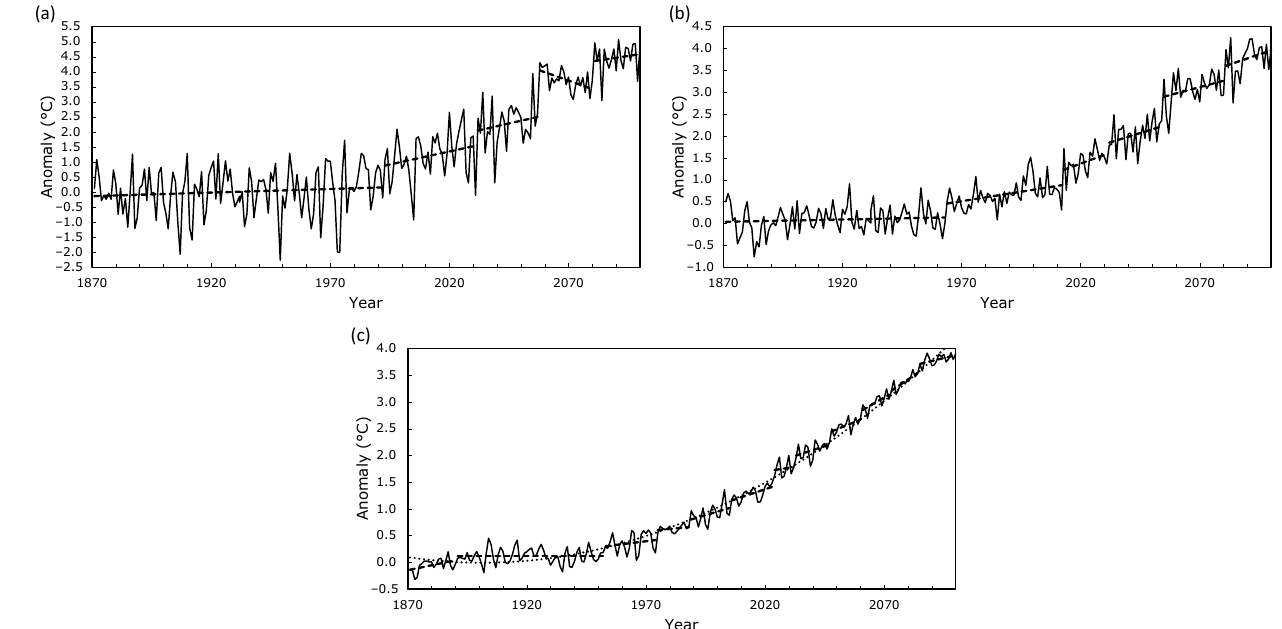
Figure 11. Anomalies of annual mean temperature showing internal trends separated by step changes from the CSIRO Mk3.5 A1B simula- tion: (a) Maximum temperature of south-eastern Australia; (b) minimum temperature of south-eastern Australia and (c) global mean surface temperature. Internal trends (dashed lines) are separated by step changes ( p